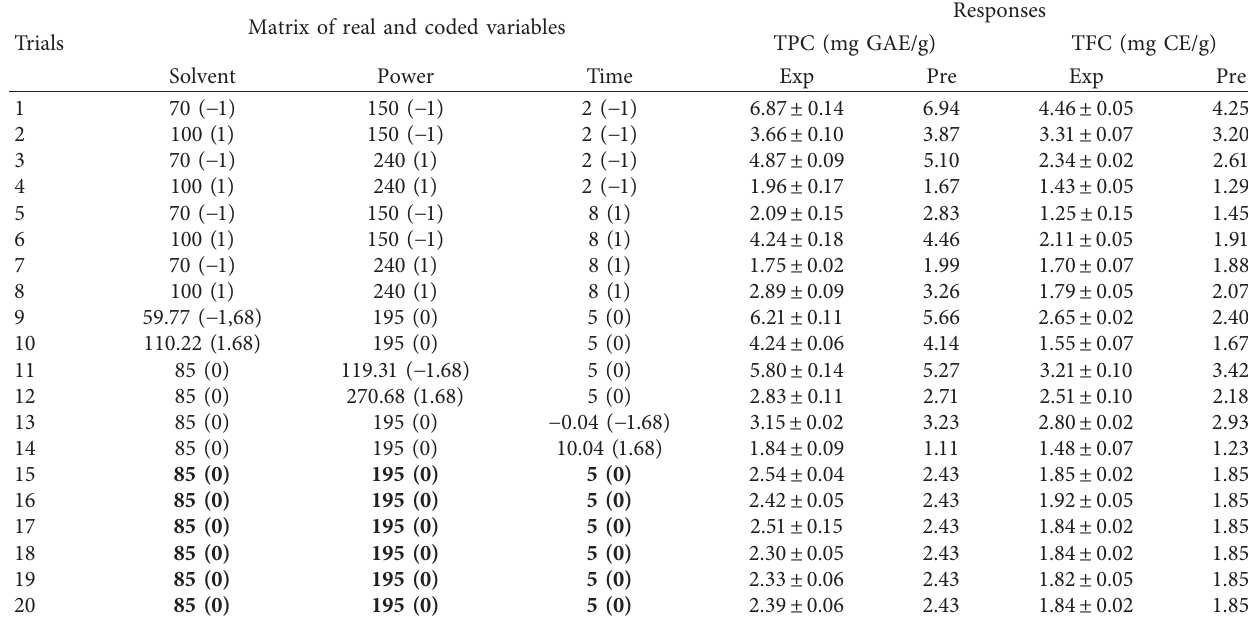
Table 4: Matrix of coded and real variables with responses obtained according to experimental conditions and predicted values.